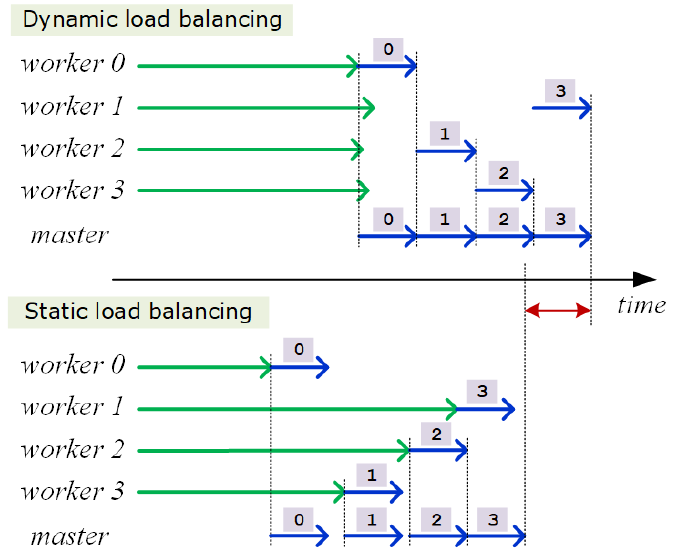
Figure 6. The situation in which static load balancing is faster than dynamic load balancing. For mo- bile wireless networks where the communication overhead is quite high compared to the workload, the static load balancing method turns out to be often faster in distributed